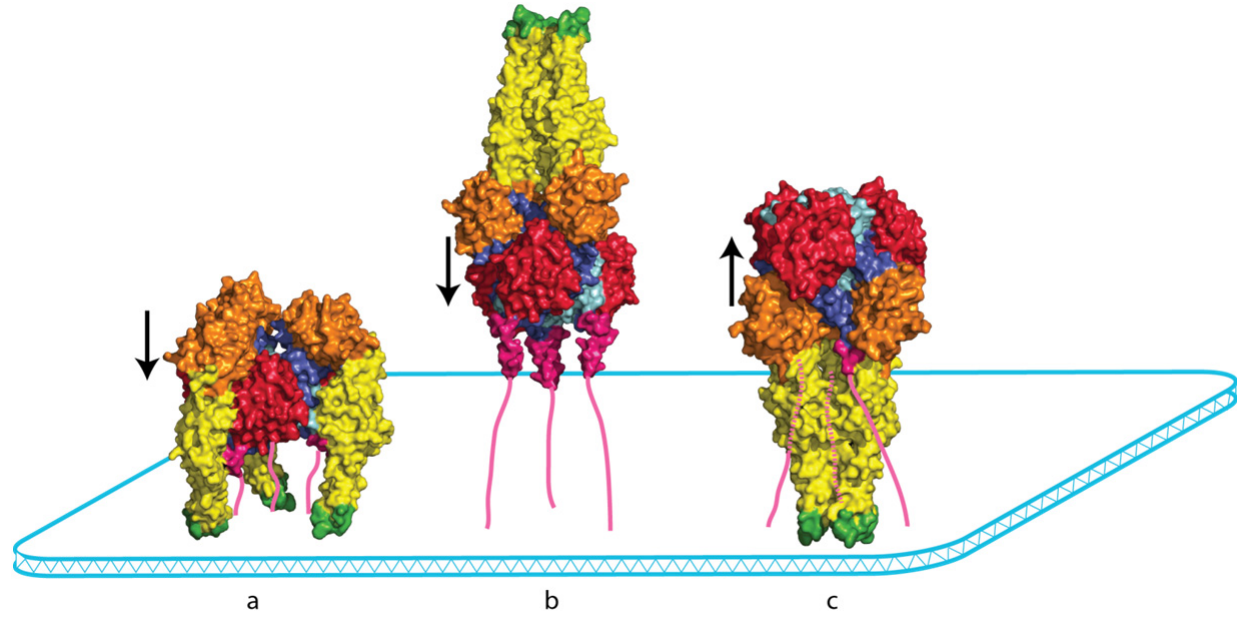
Figure 4. The topological problem associated with VSV G conformational changes. The VSV G pre- and post-fusion conformations are represented by a space-filling model viewed from the side. The C-terminal segments that reach the membrane are depicted as pink lines. In the pre-fusion conformation ( a ) and in a putative trimeric intermediate ( b ), the three fusion domains are located outside a pyramidal volume where the base would be the membrane and the sides would be defined by the ectodomain C-terminal segments. The converse occurs in the post-fusion state ( c ). Going from the pre-fusion trimer to the post-fusion trimer is very complicated, if not impossible, without monomerization. The arrows indicate the orientation of the central helices in each